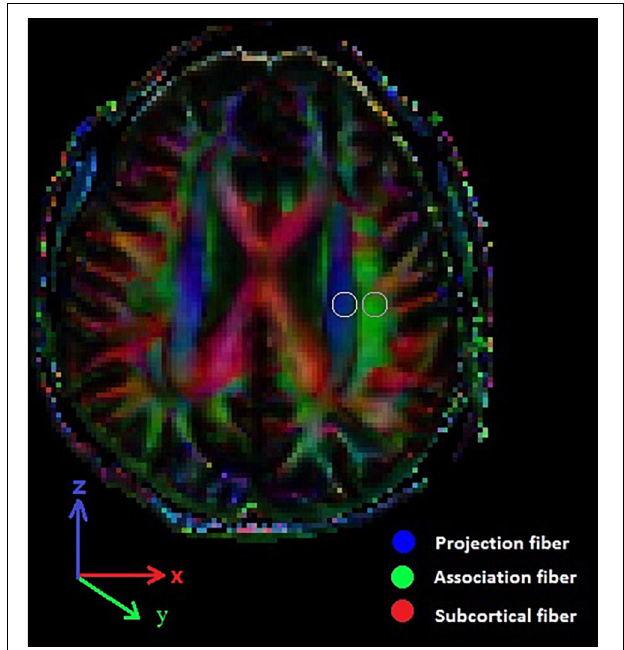
FIGURE 1 | DTI color map shows the direction of the projection fibers (blue; z-axis), association fibers (green; y-axis), and the subcortical fibers (red; x-axis). Two ROIs are placed to measure diffusivities of the projection and association